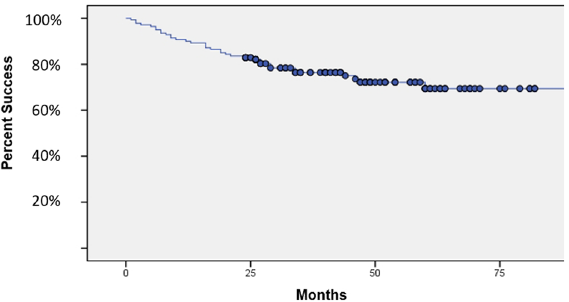
Figure 5. Kaplan–Meier curve showing success rate of the PDC based, multi-staged IMT with the end point for recurrence of infection. The success rate of multi-staged IMT at 24 months after bone grafting was approximately 80%.